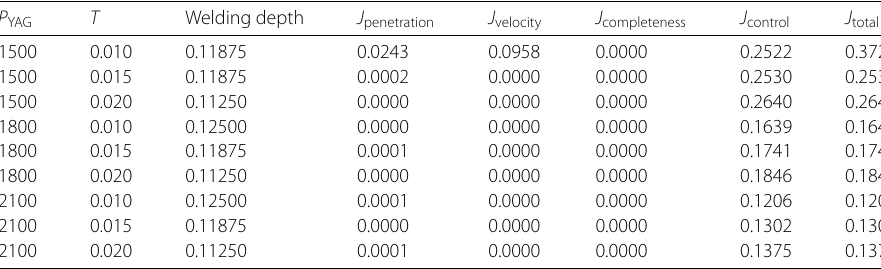
Table 3 Numerical report on the series of optimizations with zero initial guess P YAG T Welding depth J penetration J velocity J completeness J